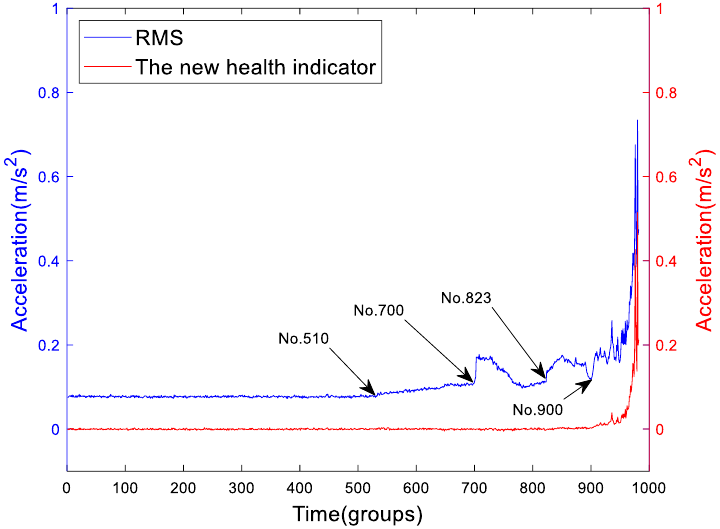
Figure 16. The RMS and the proposed health indicator of Bearing2-1IMS.